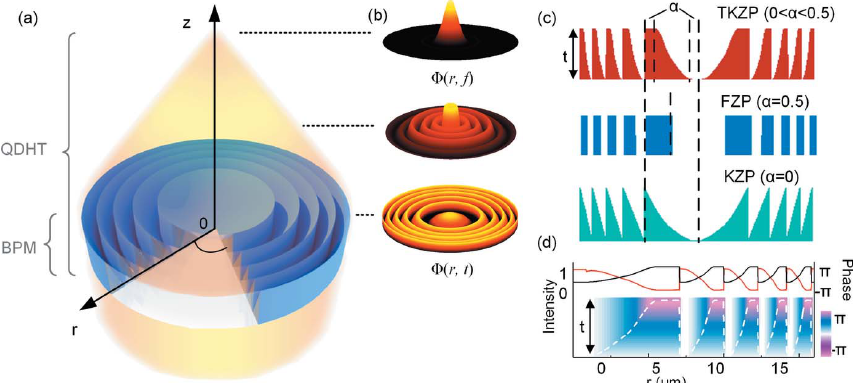
Figure 1 ( a ) Schematic illustration of the computation approach developed in this work – the traditional beam propagation method combined with the quasi-discrete Hankel transform (BPM-QDHT) in three dimensions. ( b ) The optical wavefield was calculated by BPM-QDHT to obtain (cid:2) ( r , t ) at the exit of the KZP lens. The wavefield (cid:2) ( r , f ) at the focal plane is calculated using diffraction theory and QDHTin free space. ( c ) The topography of the binary Fresnel zone plate (FZP), kinoform zone plate (KZP) and trapezoid-kinoform zone plate (TKZP). ( d ) Partial 2D phase map of the wavefields inside the TKZP with diameter of 100 m m, outermost zone width of 500 nm and thickness of 1.8 m m, and wavefield intensity (red line) and phase (black line) at the exit of the lens. The white dashed line represents the zone